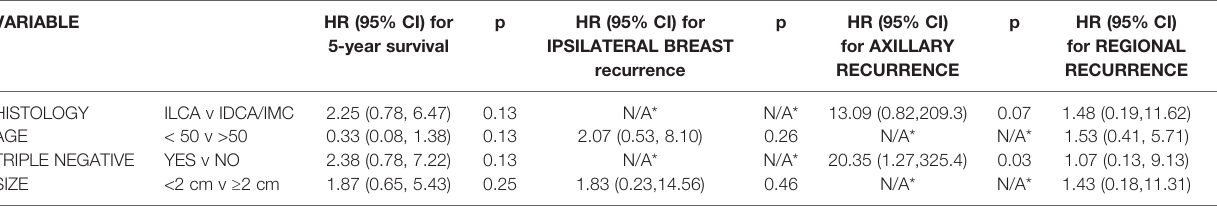
TABLE 4 | Multivariate analysis.